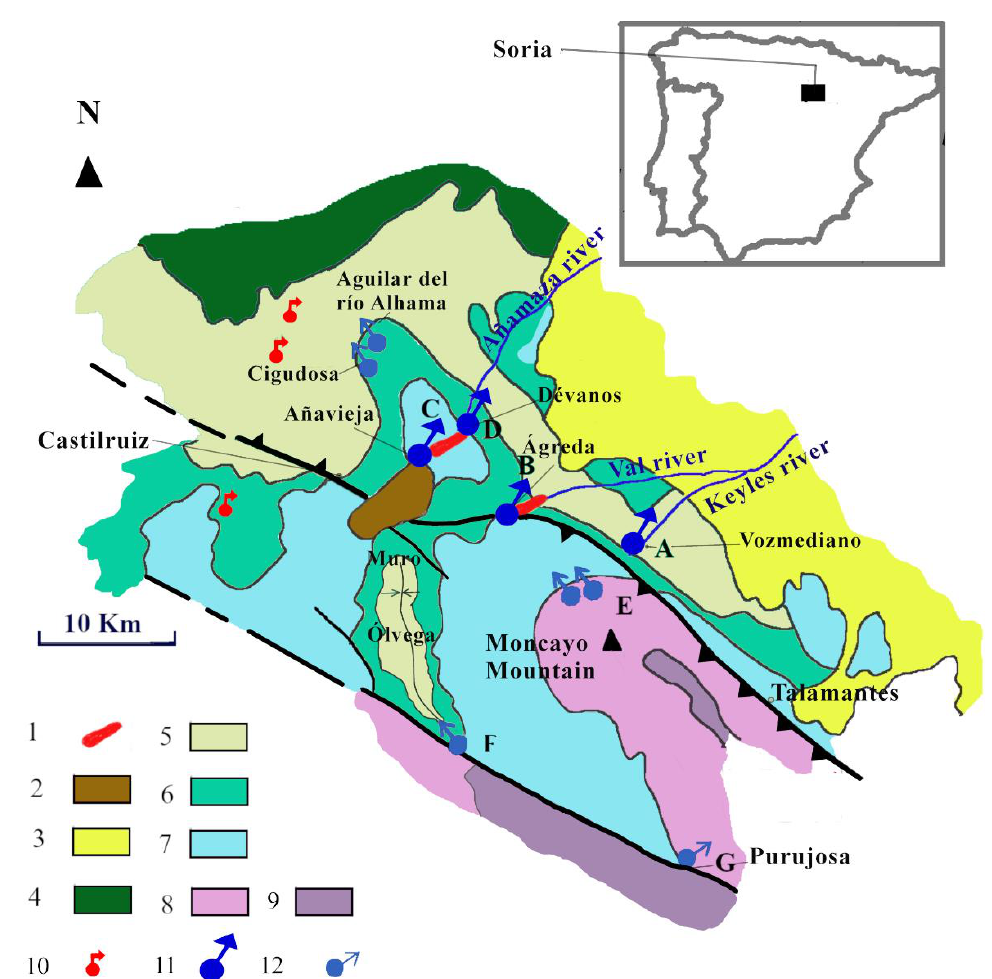
Figure 1. Geological setting of study area adapted from [27]. (1) Ó Calcareous tuffs and peats. (2) Añavieja Basin. (3) Tertiary molasses. Weald Facies ((4) Urbión Group. (5) Oncala Group. (6) Tera Group.) (7) Marine Jurassic. (8) Triassic (Buntsanstein facies). (9) Hercynian Basement. Springs: (10) Sulphuric springs, (11) Important springs with high relative sulphate content: A. Vozmediano (M. de Vozmediano 1, 2). B. Ojillos del Keyles,y Fuente de Á greda. C. Añavieja (Manantial de la Lagubna II). D. Débanos (Manadero de Dévanos), H. Castilruiz (Borehole 2, 3). (12) Springs with a low sulphate content: E. Moncayo springs (Arroyo del Moncayo, 1, 2, 3. F. Vomitrosa spring, G. Purujosa spring. H. Pozo 1 de Á greda. (13) Towns and villages.